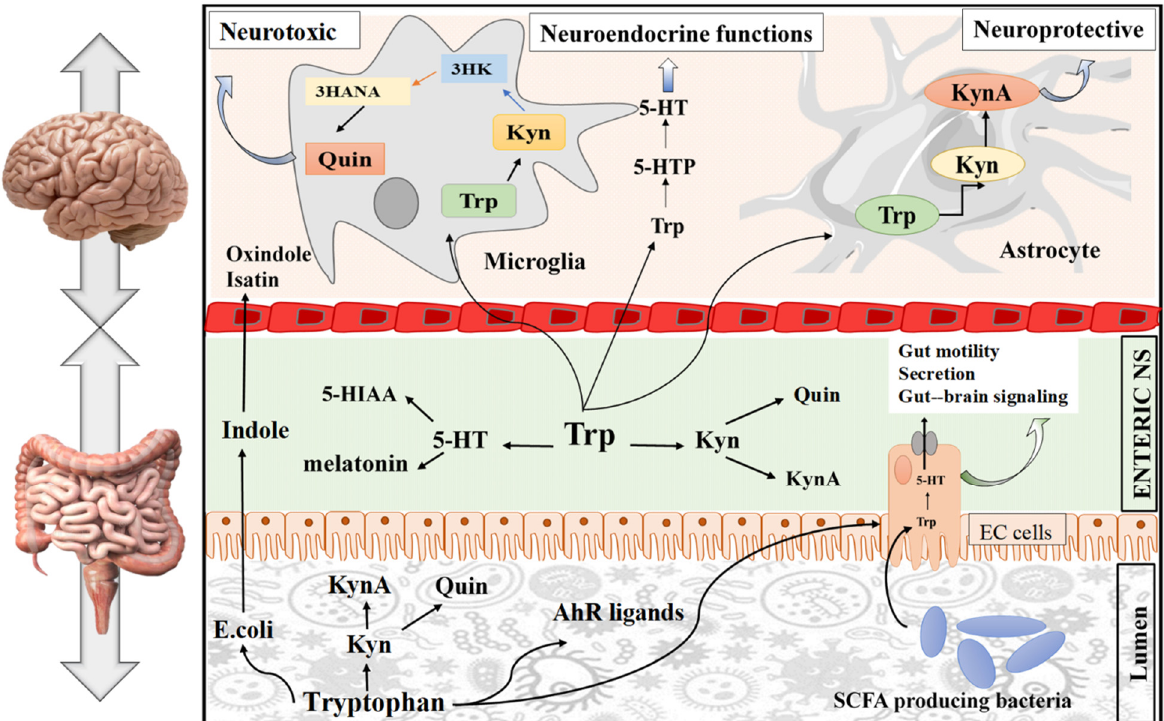
Figure 2. GBA targeting tryptophan: Peripheral serotonin synthesis by enterochromaffin cells is stimulated by gut microbiota. 5-HT from the gut has various direct or indirect effects, such as gut motility and gut microbiota. This affects central serotoninergic pathways by moderating Trp and tryptamine availability. Gut microbiota affect the kynurenine pathway, which plays a critical role in inflammatory mechanisms and neuroendocrine functions. Dietary Trp can also be directly converted by the gut microbiota into AhR ligands and can help to perform many functions. Trp; tryptophan; Kyn, kynurenine; KynA, kynurenic acid; quinolinic acid; 3HANA, 3-hydroxyanthranilic acid; 3-HK, 3-hydroxykynurenine; 5-HTP, 5-hydroxytryptophan, 5-HT, 5-hydroxytryptamine; 5-HIAA, 5-hydroxyindole acetic acid; AhR, aryl hydrocarbon receptor; EC, enterochromaffin